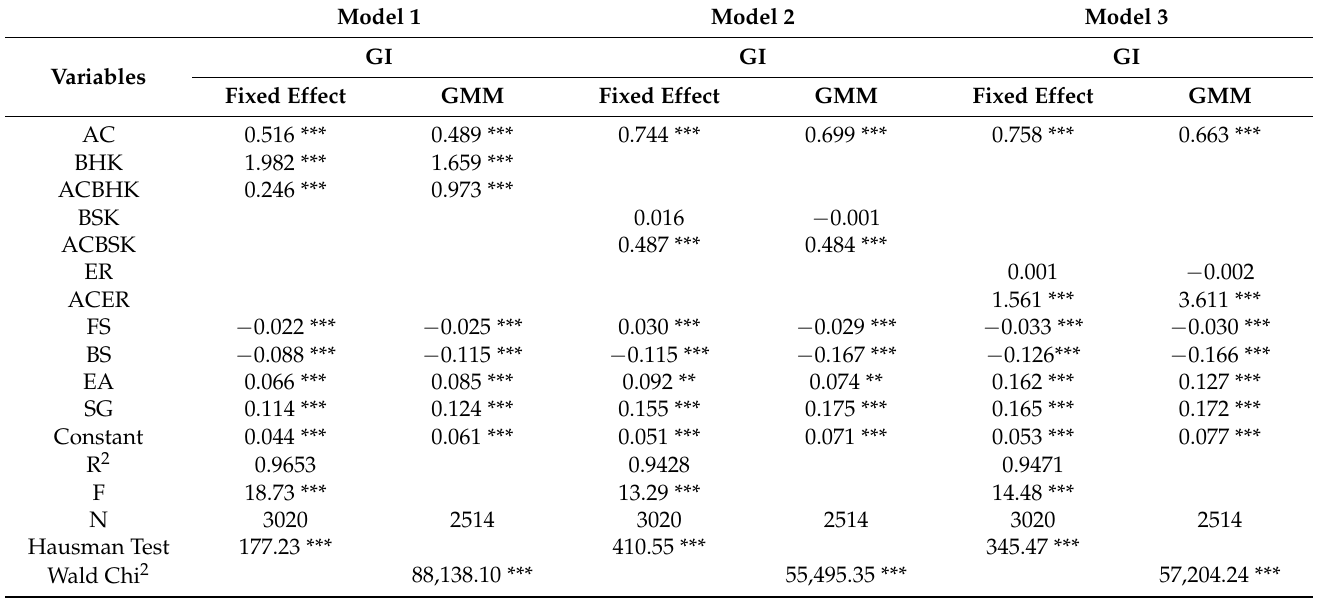
Table 3. The Interaction